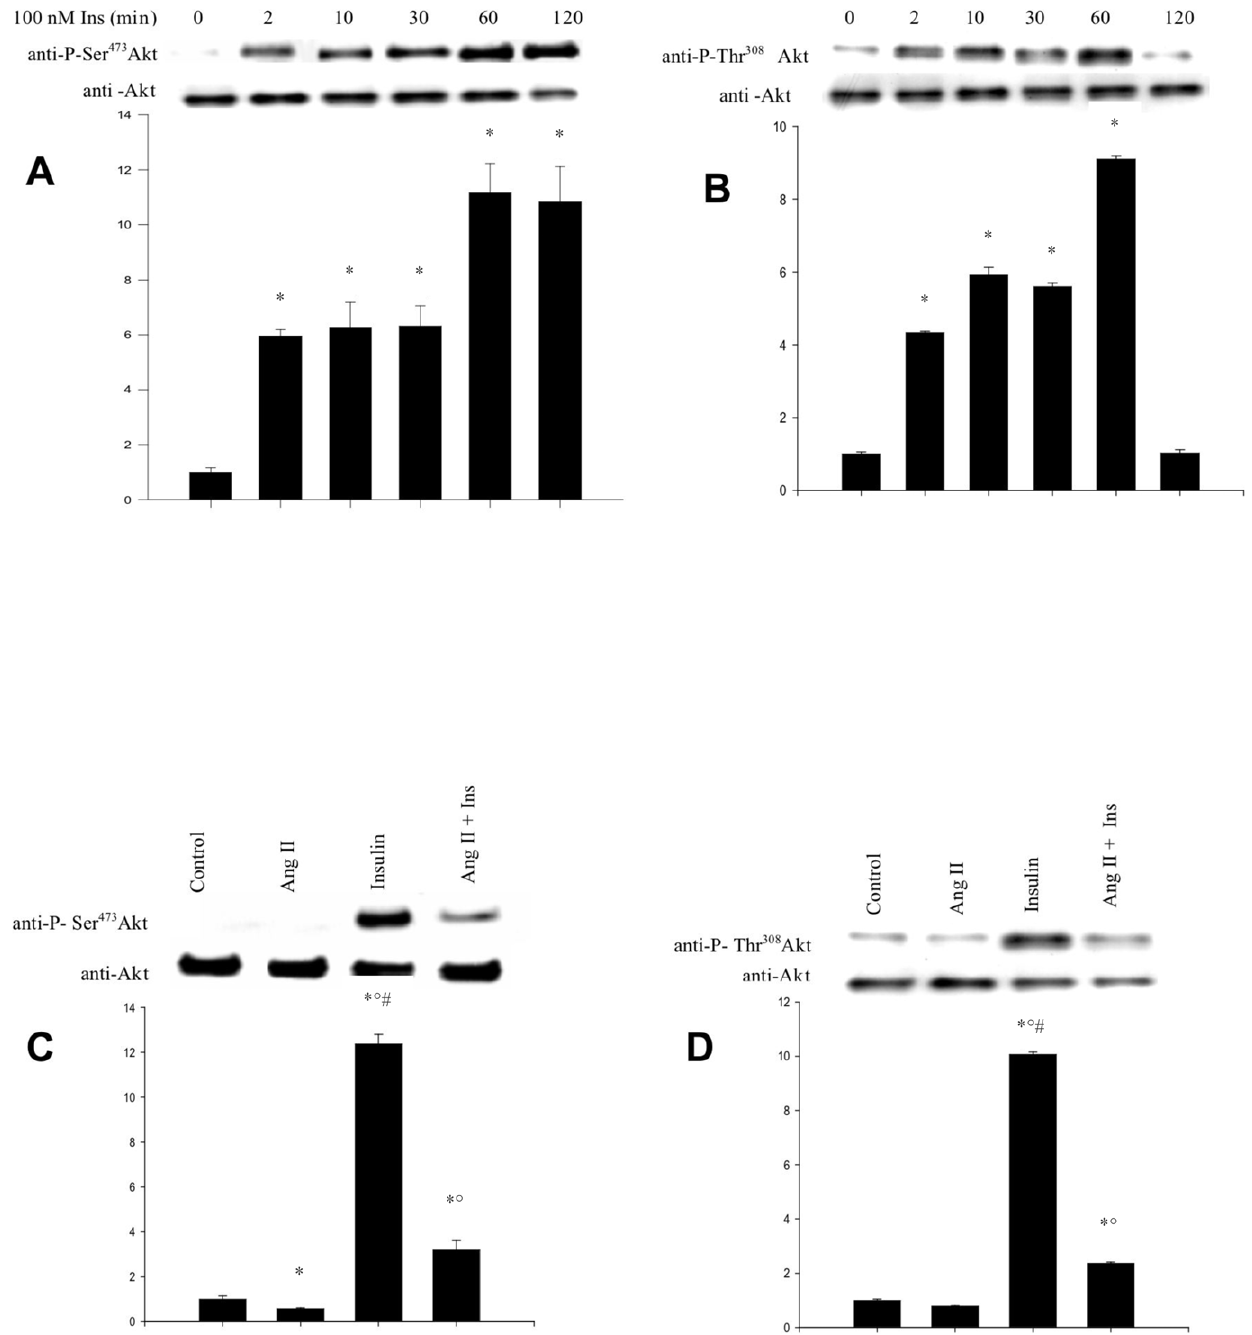
Figure2. Kinetics ofinsulin-inducedAkt phosphorylation andinhibitory effectof Ang IIon insulin-induced Aktactivation. L6 myotubes were exposed to insulin (100 nM) for 0–120 min. Blots were probed with anti-Akt and anti-phosphoSer 473 -Akt ( A ) or anti-phosphoThr 308 -Akt ( B ). L6 myotubes were pretreated with Ang II 10 nM for 30 min and stimulated with insulin (100 nM) for 60 min. Blots were probed with anti-Akt and anti- phosphoSer 473 -Akt ( C ) or anti-phosphoThr 308 -Akt ( D ) antibodies. Results are expressed as fold change of the ratio of phospho-Akt/Akt over controls (means 6 s.d.) and the blots are representative of three independent experiments (* P , 0,05 vs control, u P , 0,05 vs Ang II, # P , 0,05 vs Ang II + insulin).